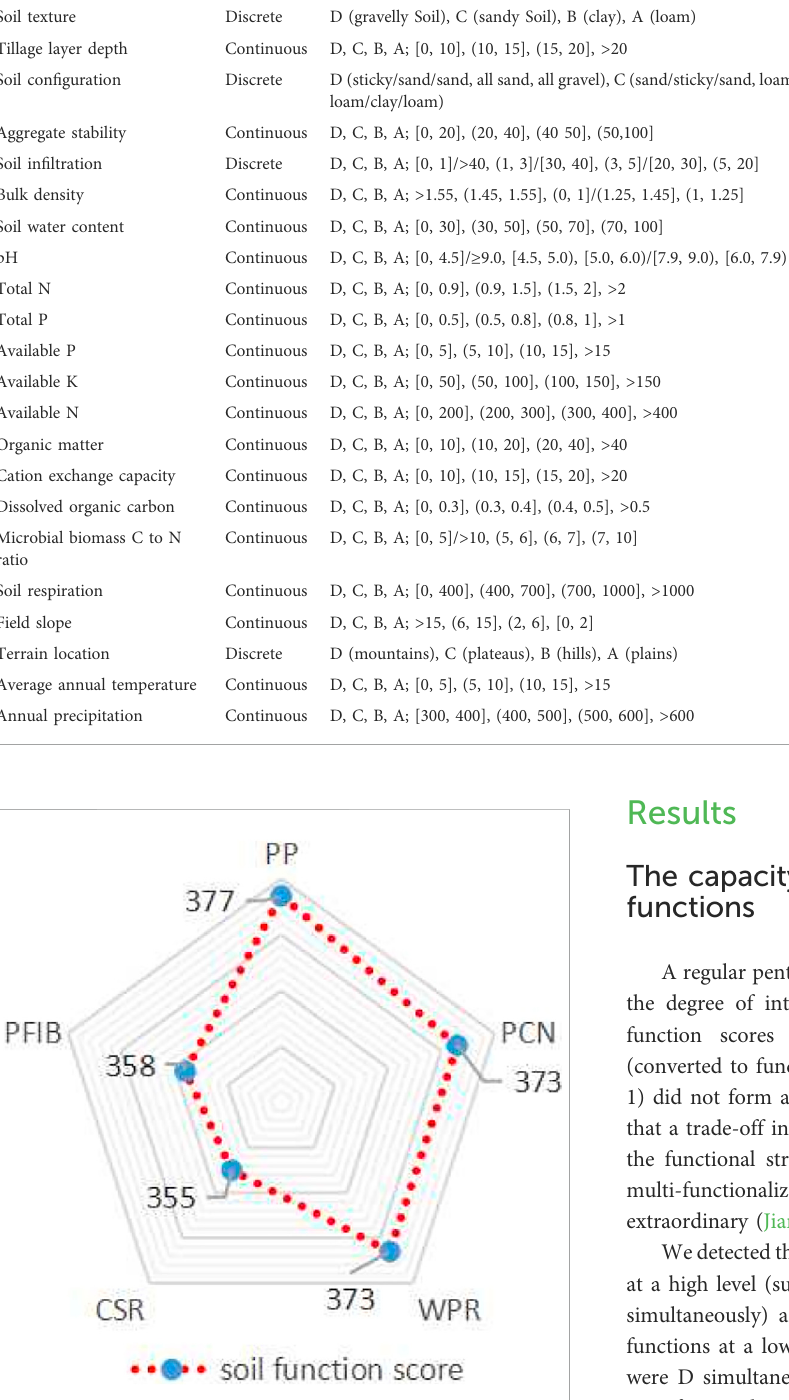
FIGURE 2 Pentagon diagram of Soil